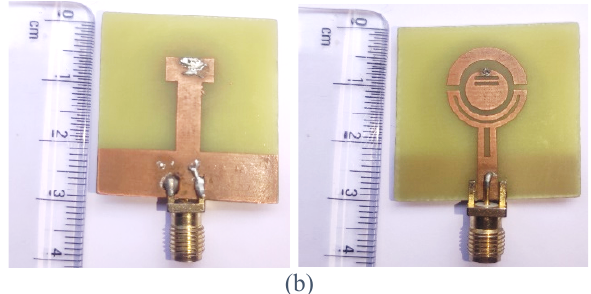
FIGURE 2. Antenna Prototype (a) Simulated Antenna (b) Fabricated Antenna